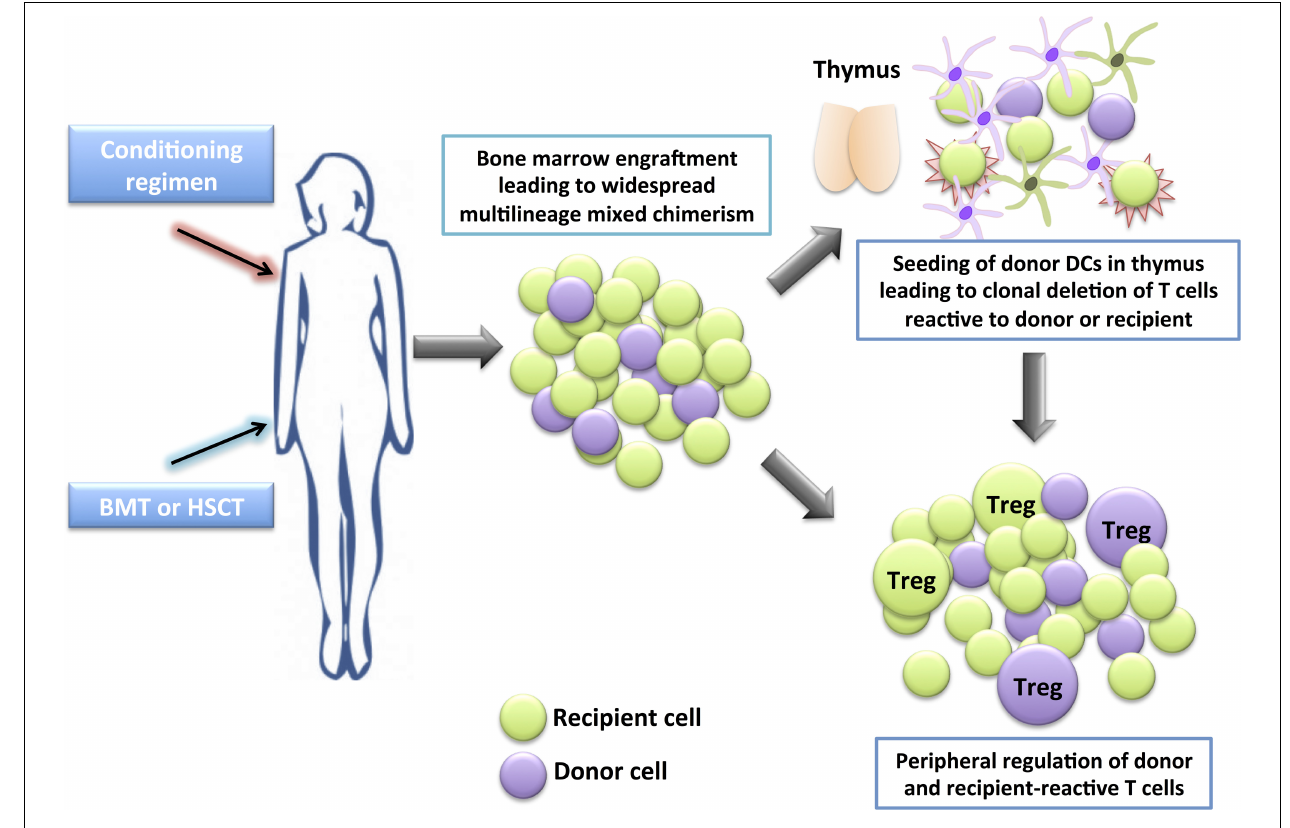
and recipient hematopoietic cells, leading to widespread multilineage mixed chimerism. Donor dendritic cells seed the thymus, and together with recipient dendritic cells, mediate central clonal deletion of newly developing donor-reactive and recipient-reactive thymocytes. Peripheral regulation also takes place whereby newly developing donor-reactive and recipient-reactive T cells that escape negative selection in the thymus are suppressed in the periphery by regulatoryT cells